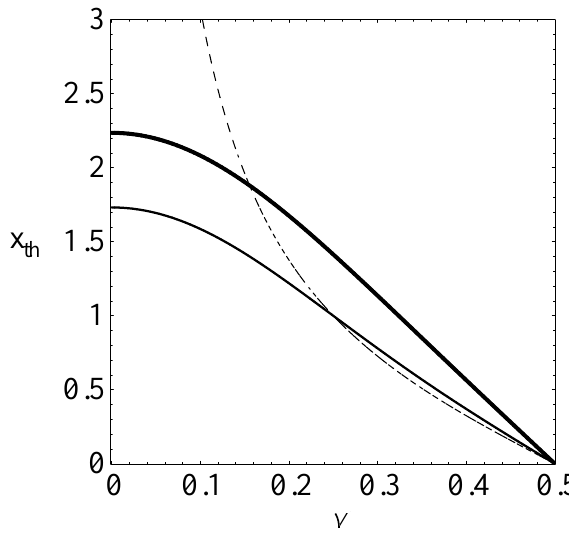
FIG. 2. The flip-flop border curves. The thick solid curve corresponds to the case of “crosswise flip,” when the vertical size of one bunch in the final state is equal to the horizontal size of its partner and vice versa. The dashed line presents the right-hand side of Eq.